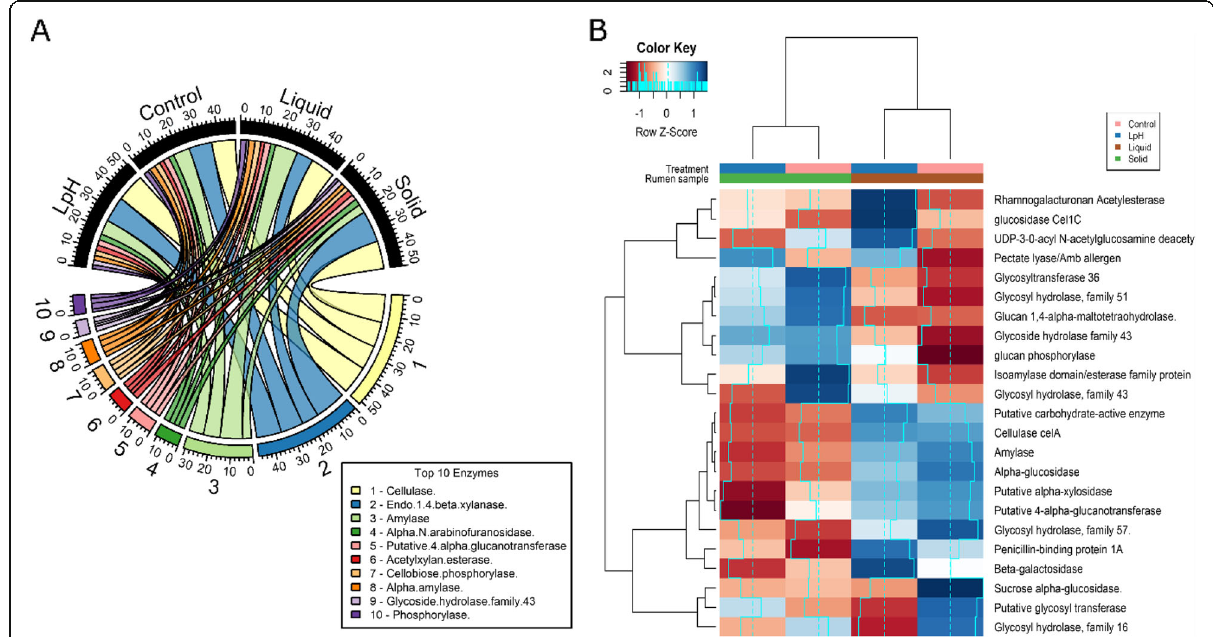
Fig. 5 mRNA expressions of the carbohydrate-active degrading enzymes. The top 10 enzymes were selected ( a ). Sequence counts were expressed as relative abundance (%). Heatmap shows enzymes that were significantly affected by pH effect and sample fractions ( b ). Rows are color coded according to Z-score. A Z-score change of + 1 is equal to one standard deviation above the row mean. Blue represents upregulation, and red represents